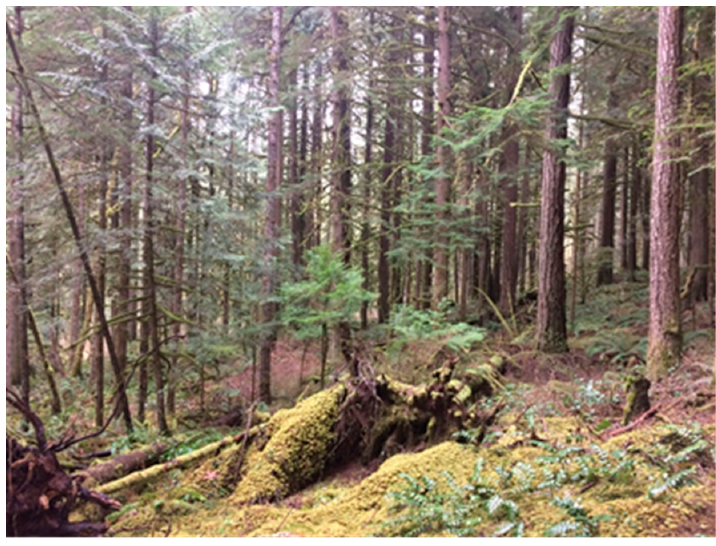
Figure 6. A mixed age, mixed species stand dominated by Douglas Fir in the Oregon Coastal Range. This stand averaged 170 mtCO 2 e/acre.